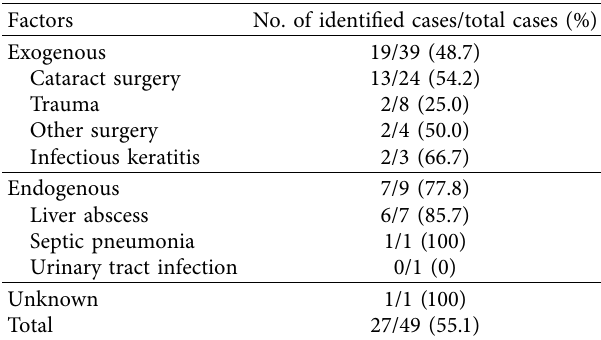
Table 2: Causative factors in infectious